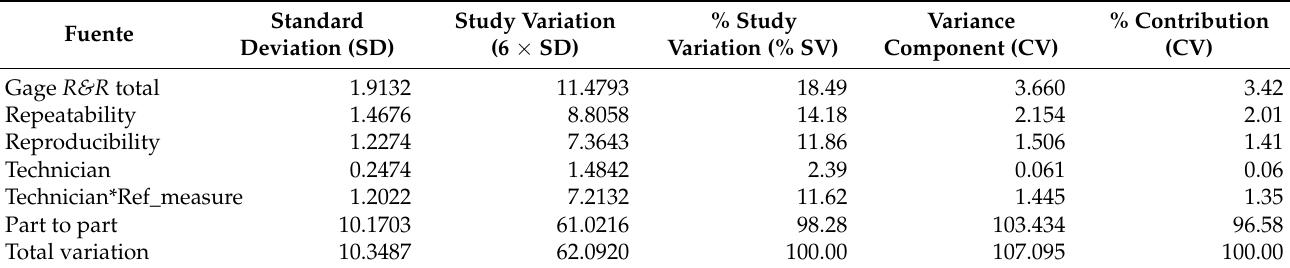
Table 2. Characterization of the honed cutting edge.